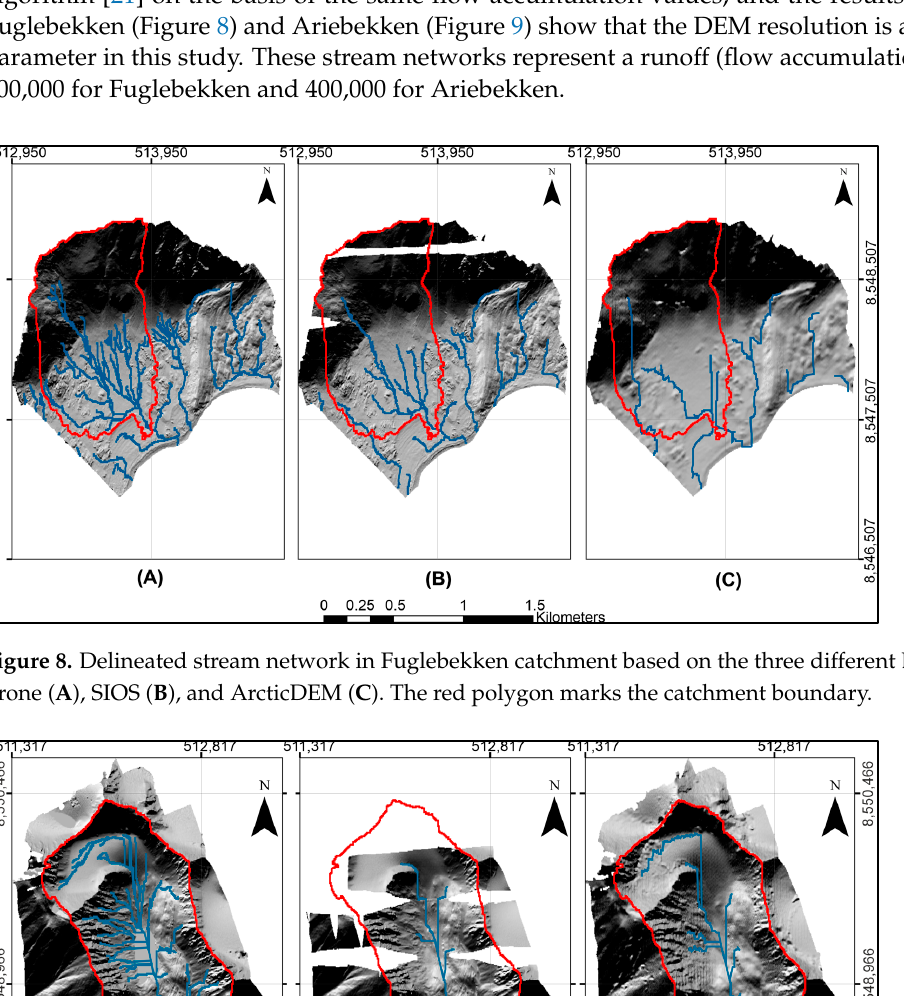
are clearly visible. There is an exception to this statement visible in Figure 9. A comparison of the stream networks derived based on SIOS DEM (B) and ArcticDEM (C) indicated that the latter is more developed despite the smaller resolution of ArcticDEM, which is a result